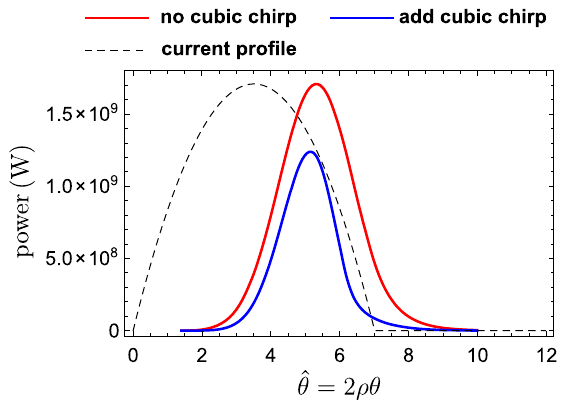
FIG. 4. Shot-averaged radiation power profiles for a matched linear chirp with or without the cubic chirp component (blue and red curves, respectively). The bunch length is 1.5 fs and we assume z ¼ 12 . 3 m. The dashed line denotes the scaled current profile.